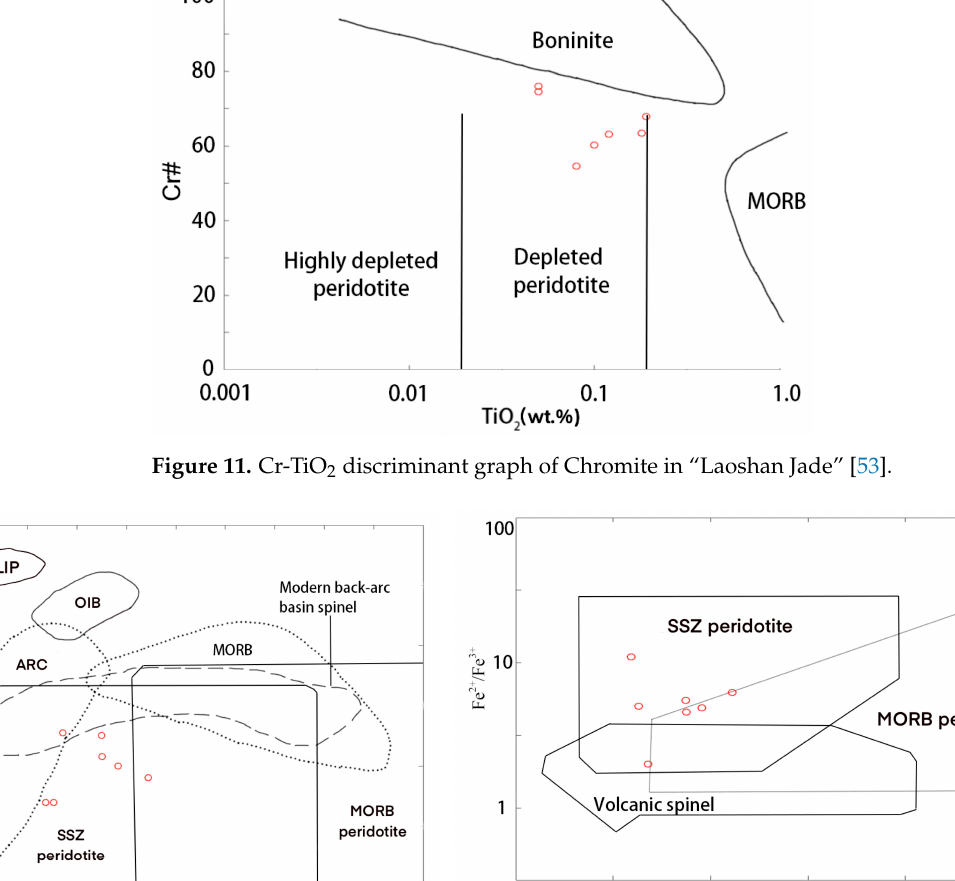
Table 6. Temperature and pressure of the chromite core in “Laoshan Jade”.